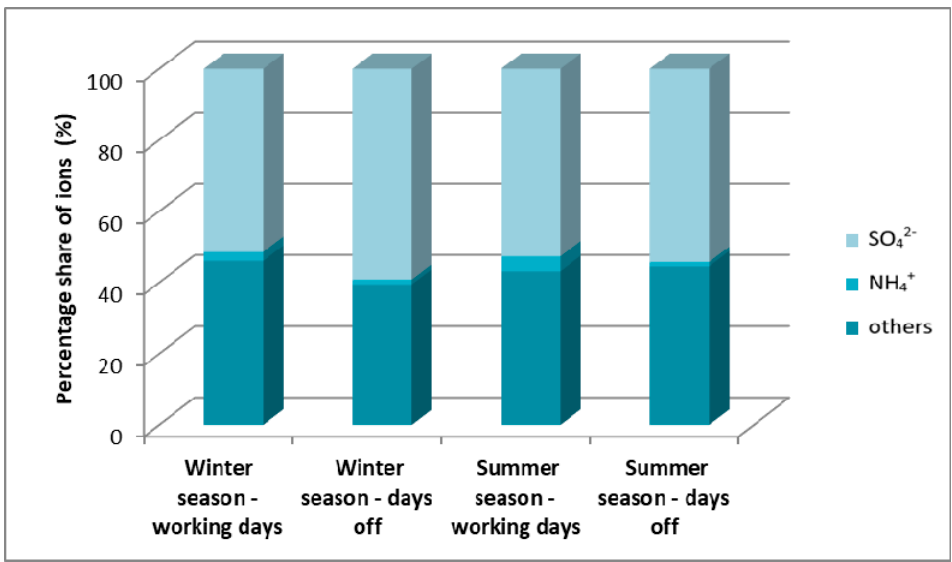
Figure 12. Mass percentage of cations and anions in the total content of ions associated with coarse particles on winter and summer working days and weekends in Zabrze in 2009 [22].